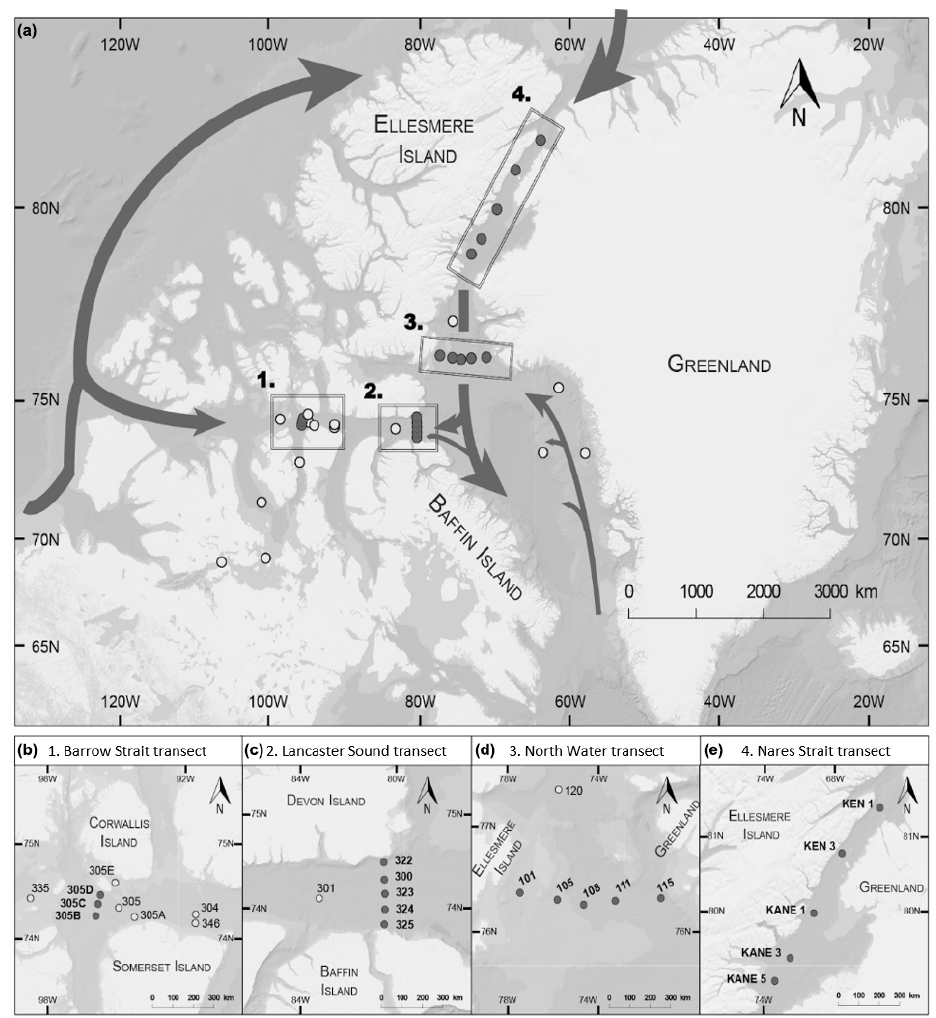
Figure 1. (a) Locations of the sampling stations in the eastern Canadian Arctic during the joint ArcticNet–NETCARE campaign in July– August 2014. Stations included in the four transects in Barrow Strait (b) , Lancaster Sound (c) , northern Baffin Bay (North Water, d ), and Nares Strait (e) are represented by closed circles. Both closed and open circles are included in global observations of surface concentrations of DMS found in Fig. 8. Major oceanic surface currents (in grey) are shown in (a)